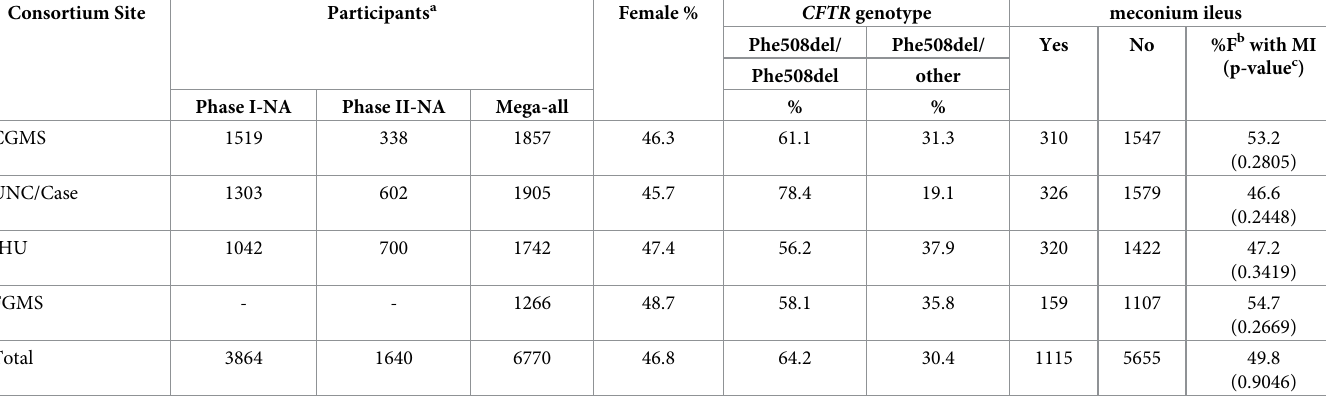
Table 1. Characteristics of CF participants included in the genome-wide study of meconium ileus from the International CF Gene Modifier Consortium (GMC). The four consortium sites are Canadian CF Gene Modifier Study (CGMS), UNC/Case Western Reserve Modifier Study (UNC/Case), Johns Hopkins University CF Twin and Sibling Study (JHU), and French Gene Modifier Study (FGMS). Additional sample details stratified by genotyping platform are provided in S1 Table. Consortium